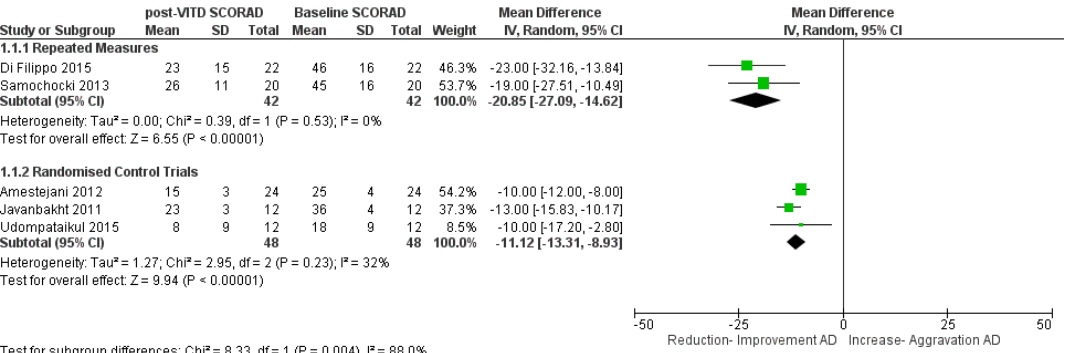
Figure 4. Meta-analysis of vitamin D intervention trials in atopic dermatitis: Comparison of clinical SCORAD index at baseline and post-vitamin D supplementation. References: Amestejani 2012